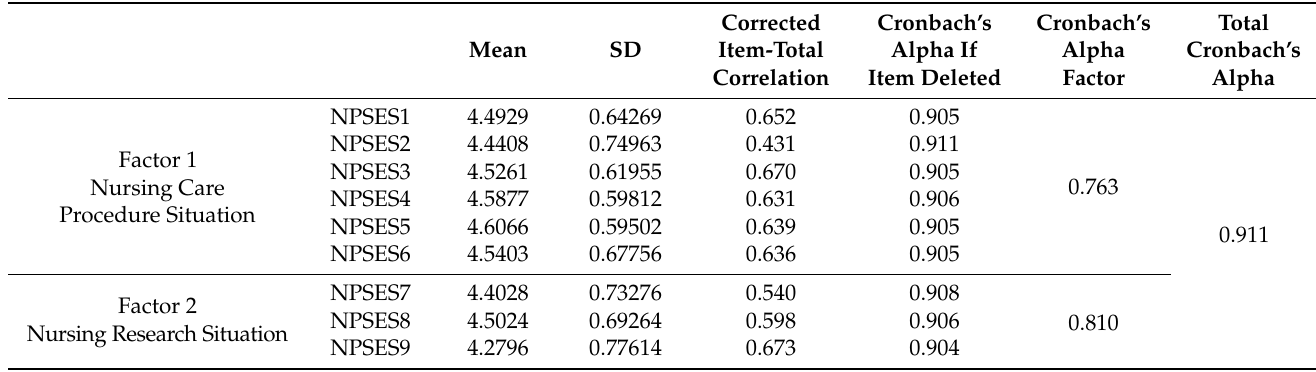
Figure 1. Structure of the Albanian version of the NPSES based on confirmatory factor analysis. Table 4. Cronbach’s alpha of